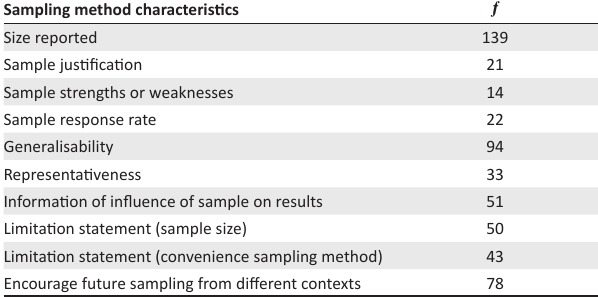
TABLE 3: Reported convenience sampling method characteristics.